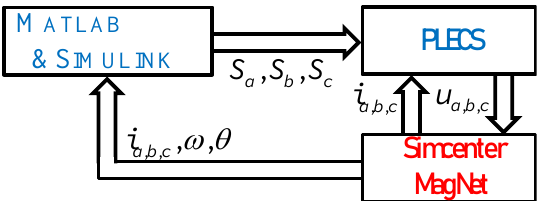
Figure 3. Data flow of the co-simulation between all software tools.